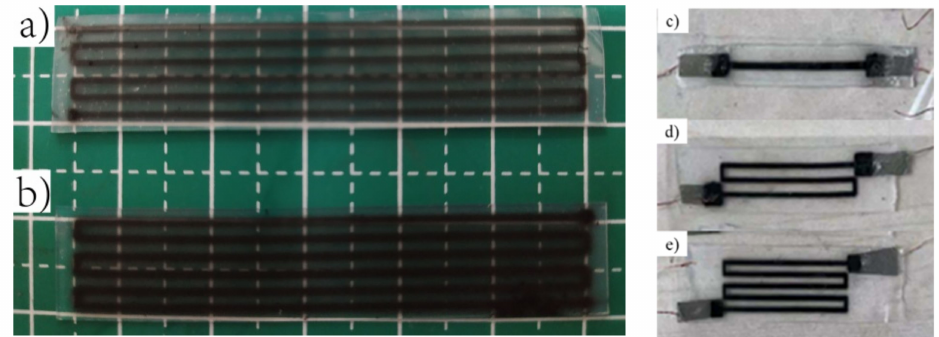
Figure 6. Flexible sensors ( a ) sensor without plasma treatment; ( b ) sensor after the plasma treatment; ( c ) sensor with a single sensing path; ( d ) sensor with three sensing paths; and ( e ) sensor with five sensing